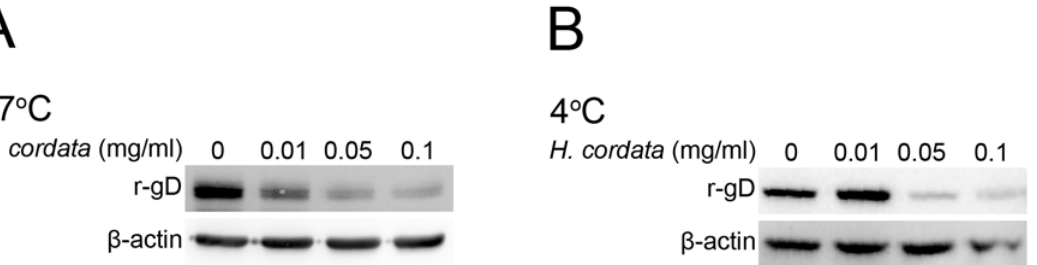
Figure 4. HCWEs block recombinant gD binding to host cells. 1X10 6 Vero cells were incubated with recombinant gD (r-gD) proteins at 37°C (A) or 4°C (B) in the presence or absence of indicated concentrations of HCWEs. Cell lysates were analyzed by Western blot assays with anti-gD and anti- β -actin antibodies. β -actin was used as an internal control for protein